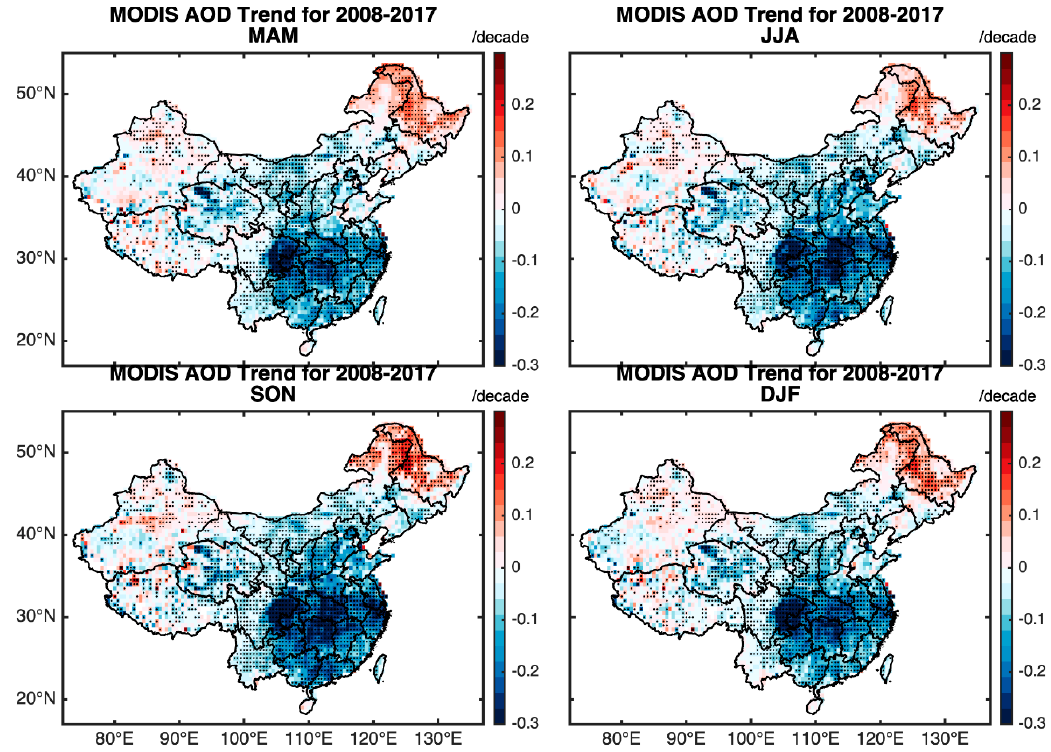
Figure 4. MODIS Terra AOD trends calculated during the 2000–2007 period for the four seasons: Spring—March, April, May (MAM); Summer—June, July, August (JJA); Fall—September, October, November (SON); Winter—December, January, February (DJF). The trends were calculated as the Sen’s slope and tested using the Mann–Kendall test. Trends with significance level >95% are marked with black dots.